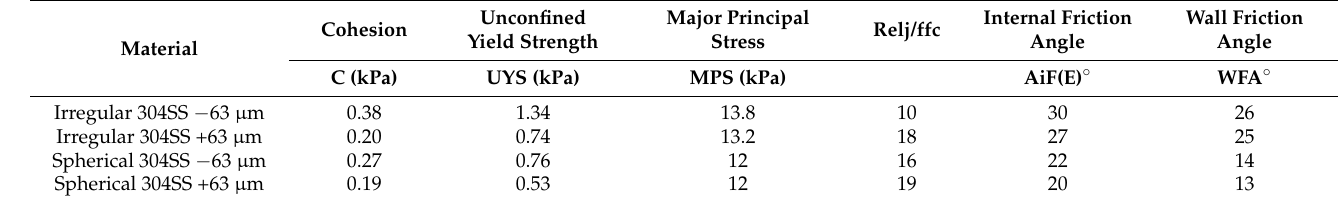
Table 8. Powder flow